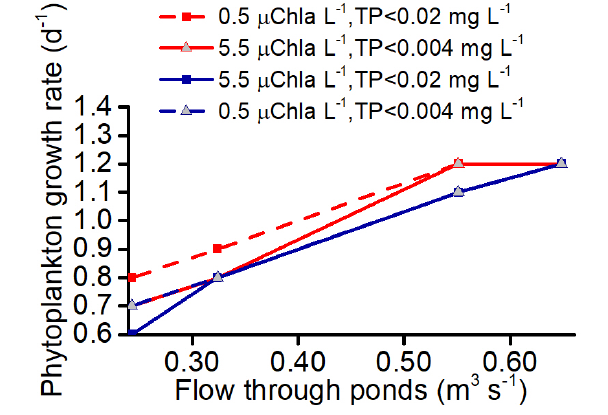
Fig. 5 . Modeling results: phytoplankton growth as a function of groundwater inflow through the ponds. Dashed lines indicate conditions for which macrophyte domination was maintained, whereas the solid lines indicate that a switch to phytoplankton would be observed.